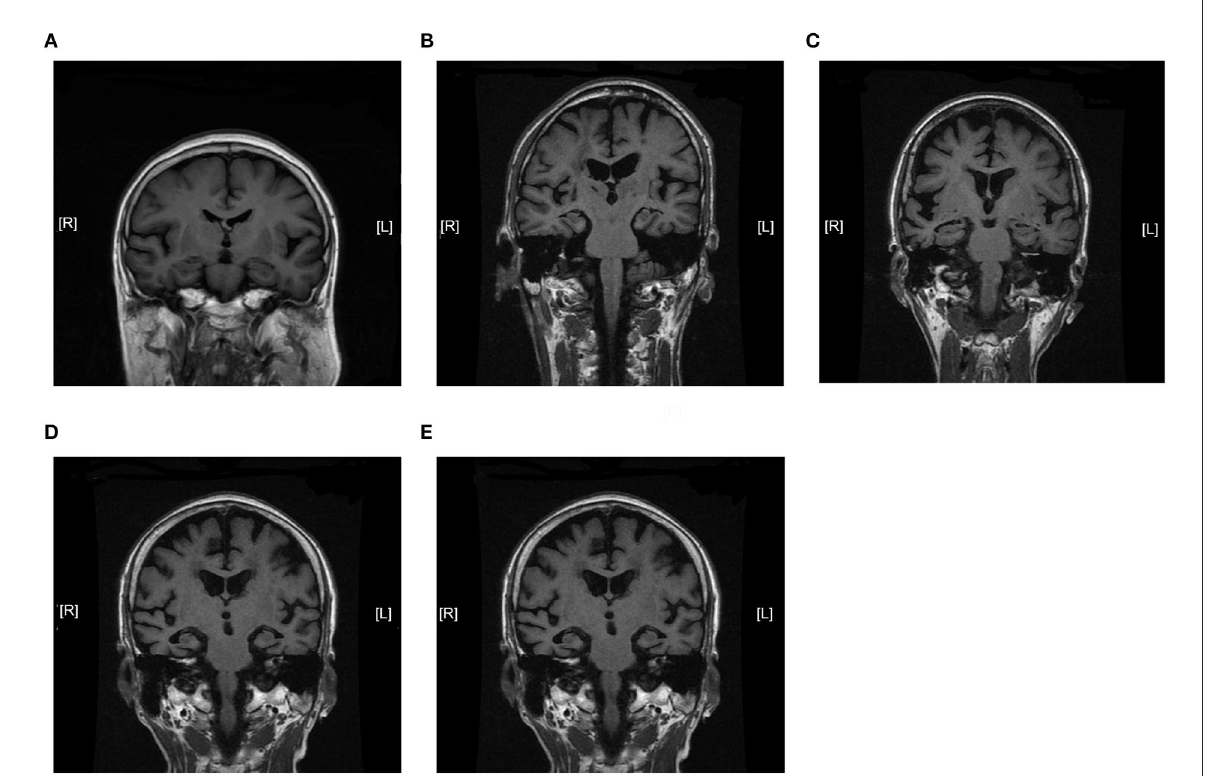
FIGURE2 Magnetic resonance imaging coronal view of the hippocampus in T1-weighted images. MTA scores were used to assess AD progression. The degree of MTA correlates with AD severity. (A) MTA = 0. (B) MTA = 1. (C) MTA = 2. (D) MTA = 3. (E) MTA = 4. MTA: medial temporal lobe atrophy scale. MTA scores range from 0 to 4.